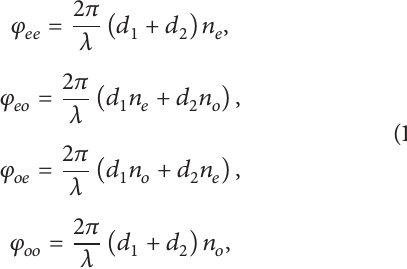
Figure 2: The orientation of the optical axes of crystal plates in relation to the planes of polarizer and analyzer transmission. P = transmission plane of polarizer; A = transmission plane of analyzer; 𝑧 1 , 𝑧 2 = optical axes of the first and second crystal plates, respectively; 𝛼 = 𝛾 = 45 ∘ ; 𝛽 = 90 ∘ .